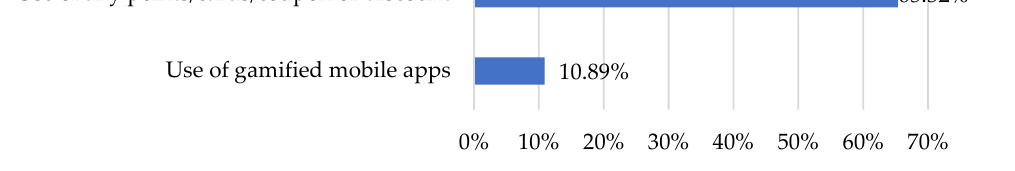
Figure 1. Respondents’ contact with gamification systems ( n = 248).